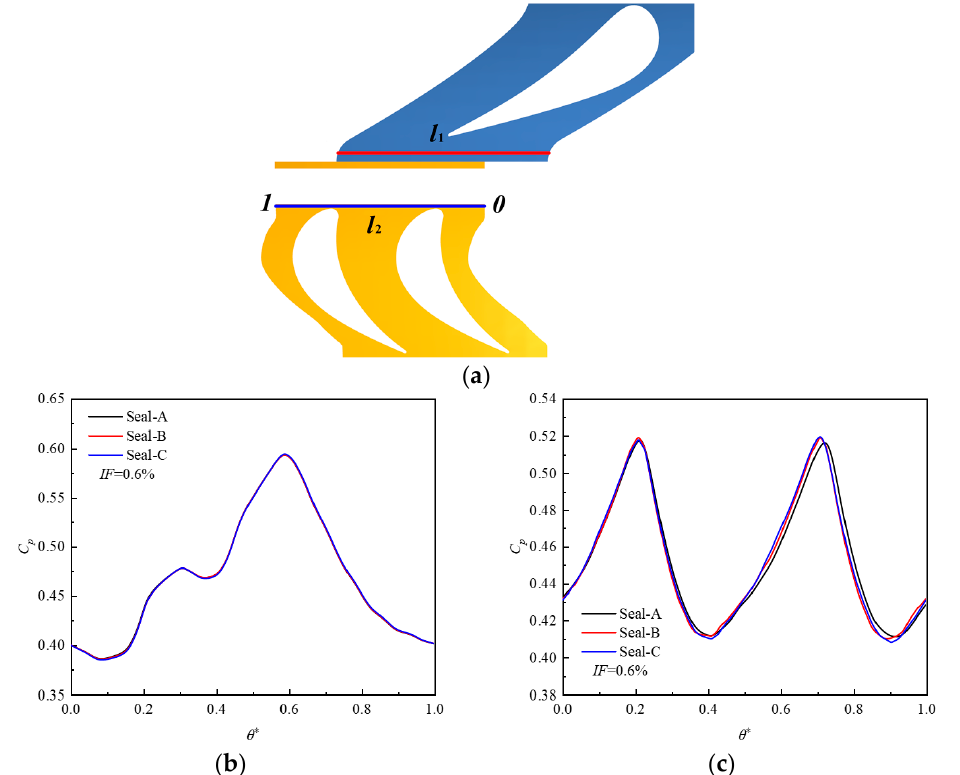
Figure 19. Time-averaged static pressure coefficient distribution at l 1 (downstream of the vane trailing edge) and l 2 (upstream of the blade leading edge) for IF = 0.6%: ( a ) position of curves on the vane endwall and the blade endwall; ( b ) vane endwall; ( c ) blade endwall.